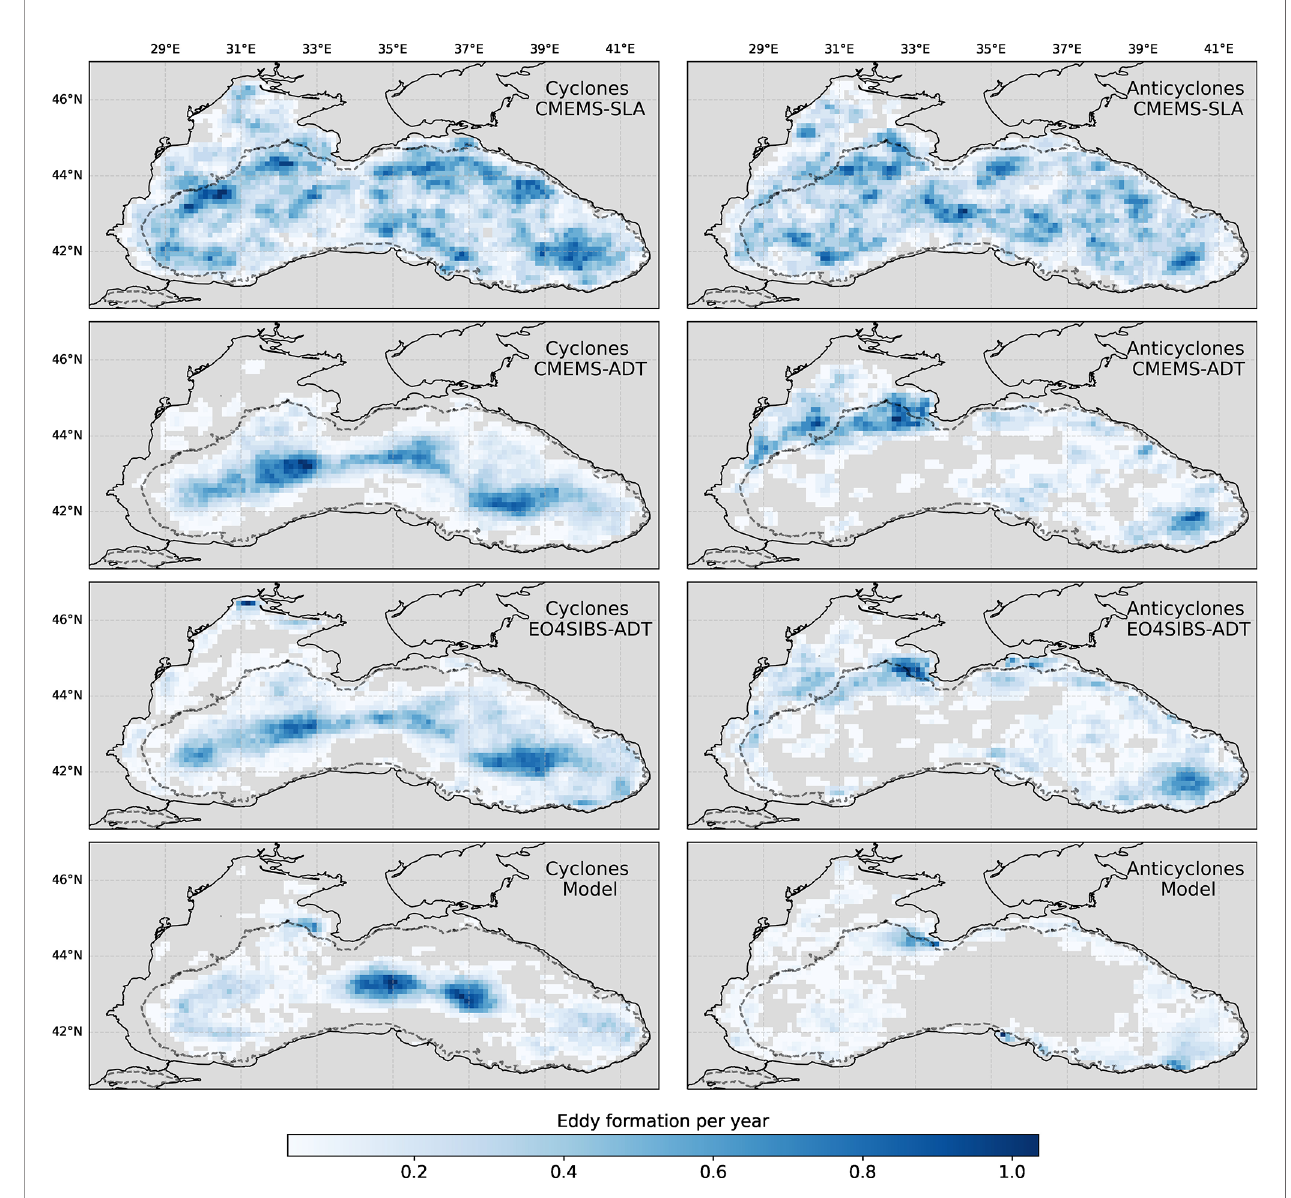
FIGURE 7 | Annual frequencies of eddies formation events, including both cyclones and anticyclones, as obtained from the different data sets. The dotted line indicates the 200m isobathymetric